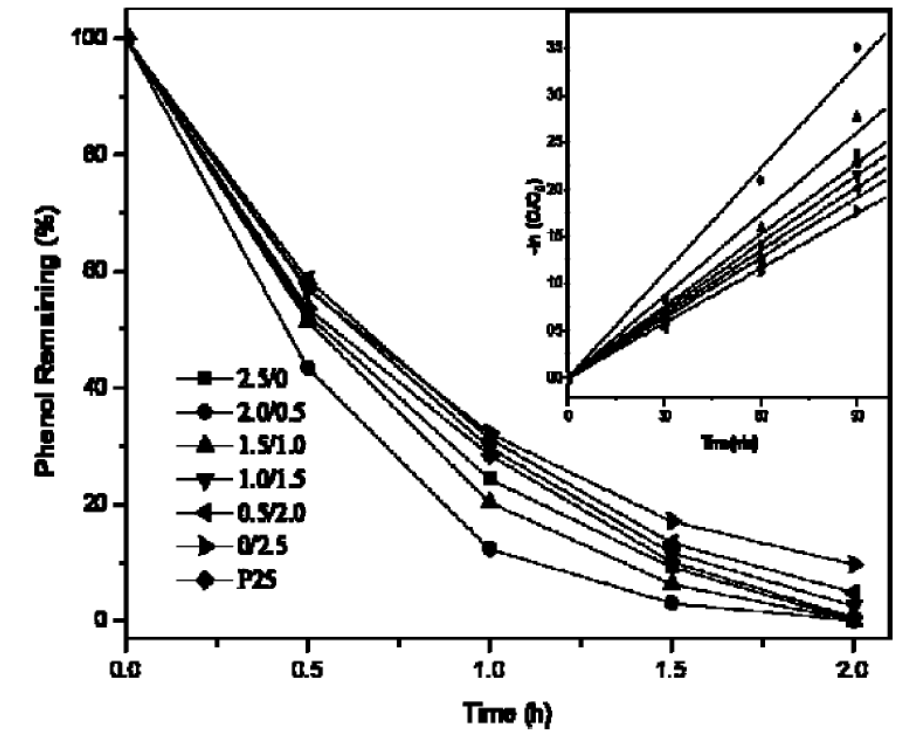
Figure 24. Phenol photodegradation using mesoporous TiO from [84]. 2007 American Chemical